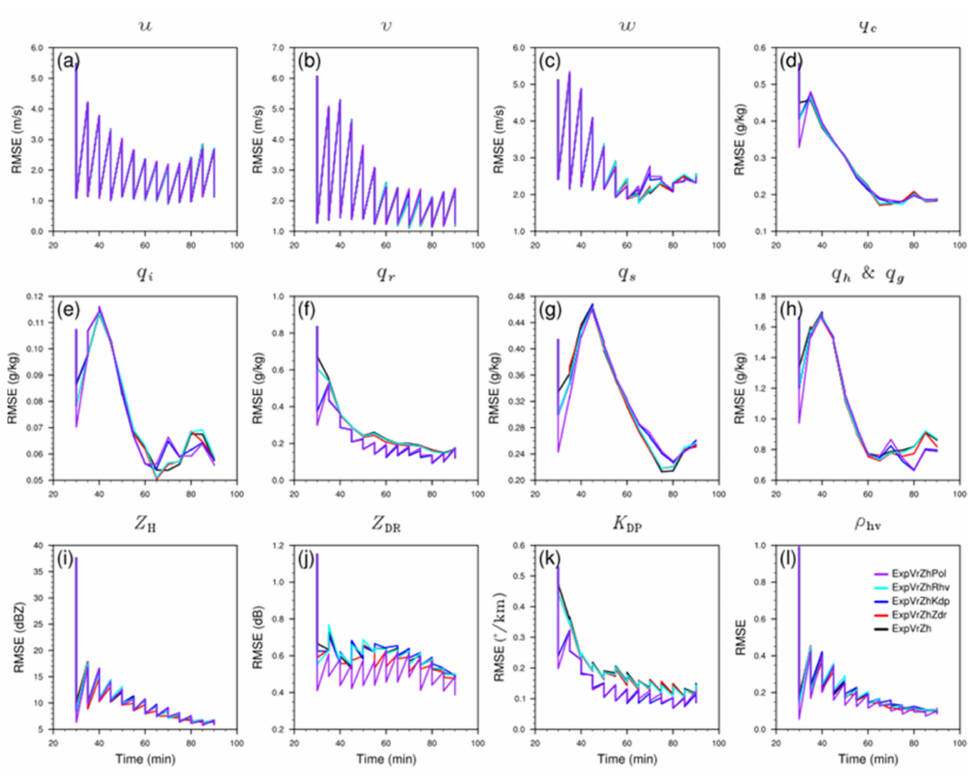
Figure 2. The mean RMSEs of the forecasts and analyses throughout the 5 min 3DVAR DA cycles for ExpVrZh (black line), ExpVrZhZdr (red line), ExpVrZhKdp (blue line), ExpVrZhRhv (cyan line), and ExpVrZhPol (purple line), respectively, averaged over grid points where the observed (simulated) Z H is greater than 10 dBZ. ( a ) u , ( b ) v , ( c ) w , mixing ratios of ( d ) cloud water q c , ( e ) cloud ice q i , ( f ) rain water q r , ( g ) snow q s , ( h ) hail q h , and graupel q g , and the same calculating procedure as truth simulations for polarimetric radar variables ( i ) Z H , ( j ) Z DR , ( k ) K DP , and ( l ) ρ hv via Z21